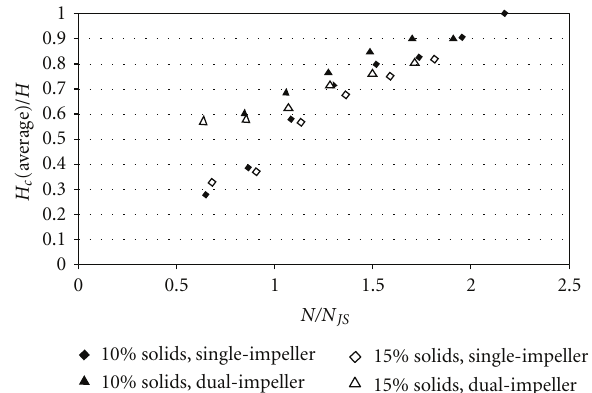
Figure 2: Fractional average cloud height ( H c / H ) as a function of impeller speed normalized by N JS for the single- and dual-impeller configurations for 10% (w/w) and 15% (w/w)